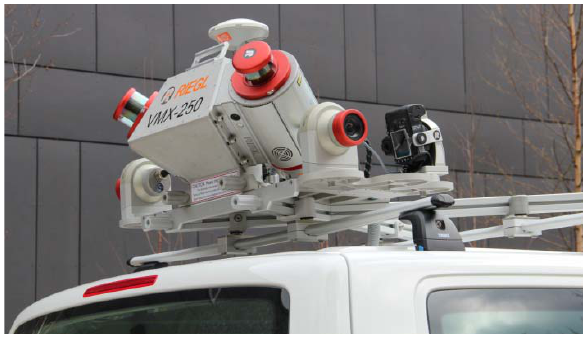
Figure 2. Riegl Mobile Mapping